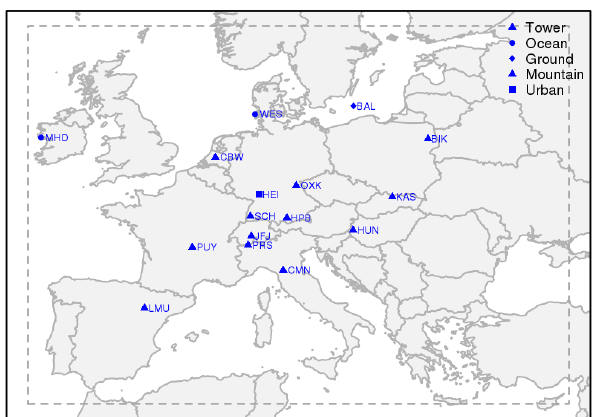
Figure 1. Domain of the inversions (dashed rectangle). Locations of the atmospheric measurement stations are shown with blue marks. Table 1. Optimized VPRM parameters SW 0 , λ SW , α and β for dif- ferent vegetation classes. ∗ SW 0 λ SW α β Evergreen forest 275 0.226 0.288 − 1.10 Deciduous forest 254 0.215 0.181 0.84 Mixed forest 446 0.163 0.244 − 0.49 Open shrub 70 0.293 0.055 − 0.12 Crop 1132 0.086 0.092 0.29 Grass 528 0.119 0.125